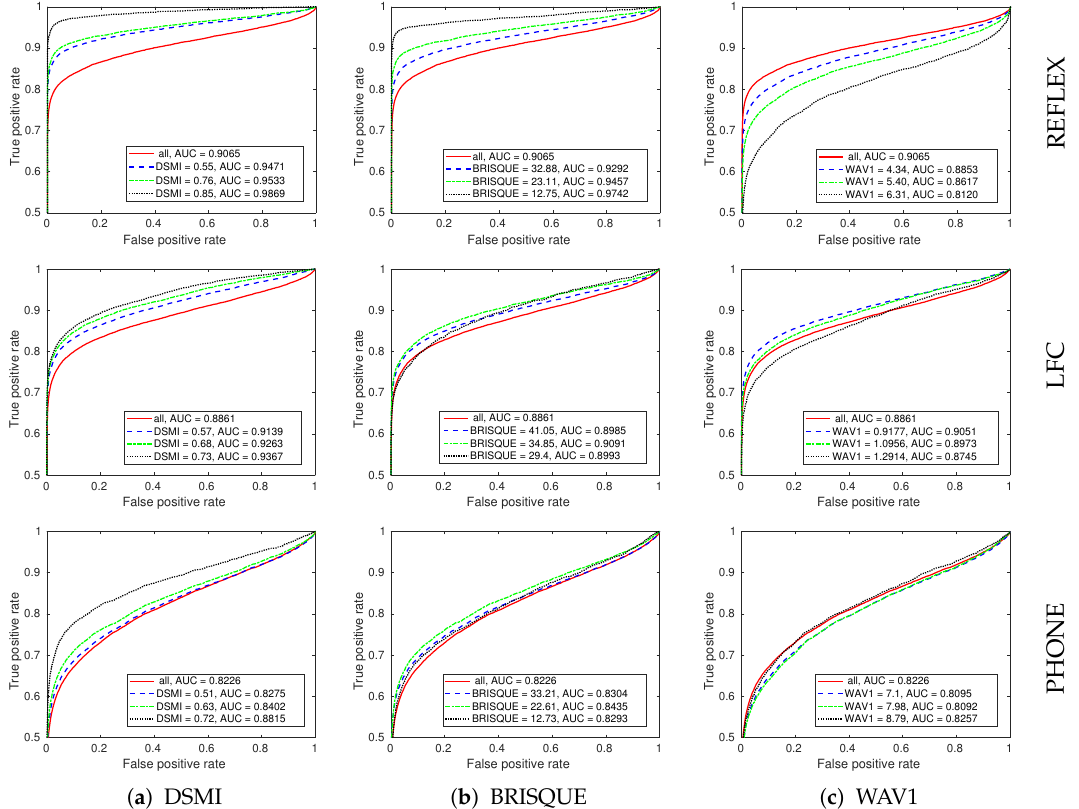
Figure 8. The receiver operating characteristic (ROC) curves for the three test datasets (REFLEX, LFC, and PHONE) with different quality filtering thresholds using our DSMI metric, BRISQUE, and WAV1. The solid red, dashed blue, dot-dashed green, and dotted black lines were plotted without quality filtering, after filtering out one-quarter, half, and three-quarters of the poorest-quality images,